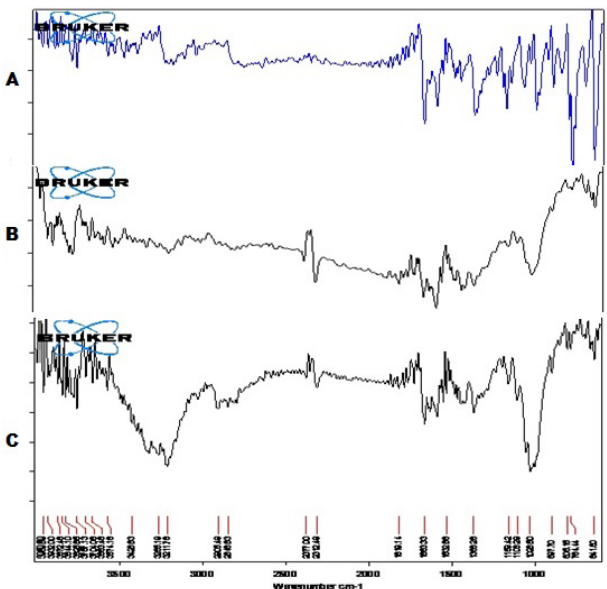
FIGURE 6 - FTIR spectrum of A) pure drug of Hydralazine hydrochloride B) Drug, carbopol 934Pand HPMC K4M C) Drug, carbopol 934P and Na